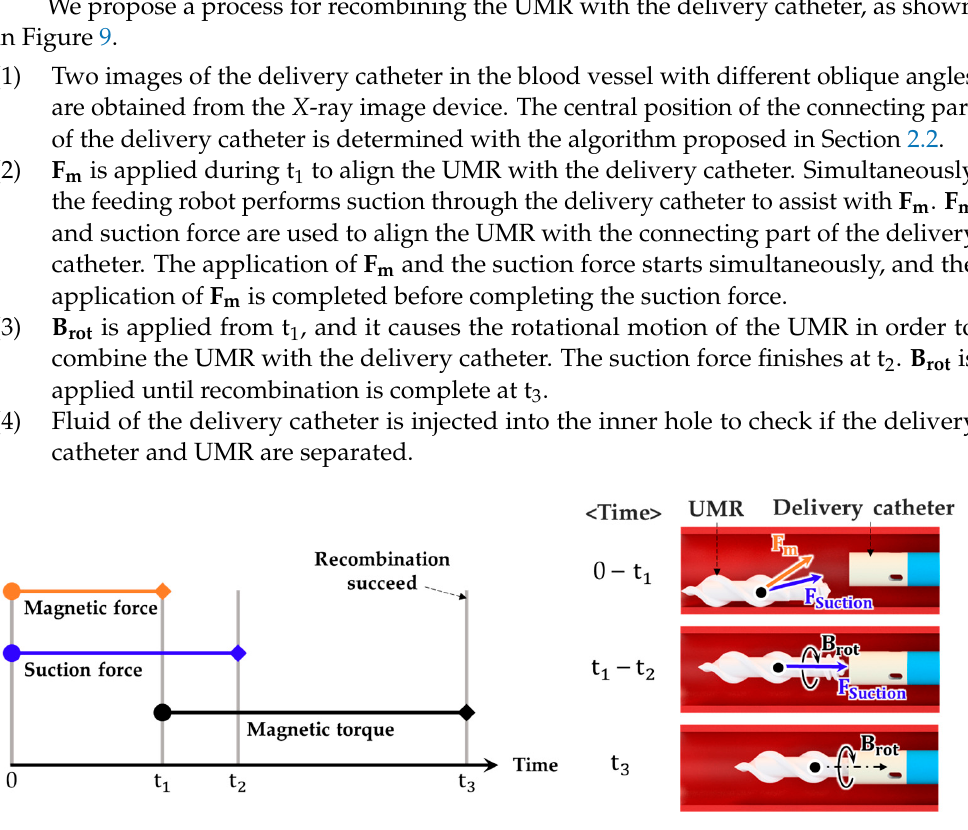
( c ) Figure 10. ( a ) Experimental setup for the in vitro experiment on the retrieval process; ( b ) 17 recom- bining positions; ( c ) oblique angle ( α 1 = 0°, α 2 = − 90°) and shooting direction of the RGB camera. The algorithm presented in Section 2.2 was utilized to determine the location of the connecting part in the cross-section of the glass tube by using the images that were shot. Table 1 and Figure 11 show the results of a comparison of the actual and calculated posi- tions for 17 points at the center of the connecting part. The calculated positions matched